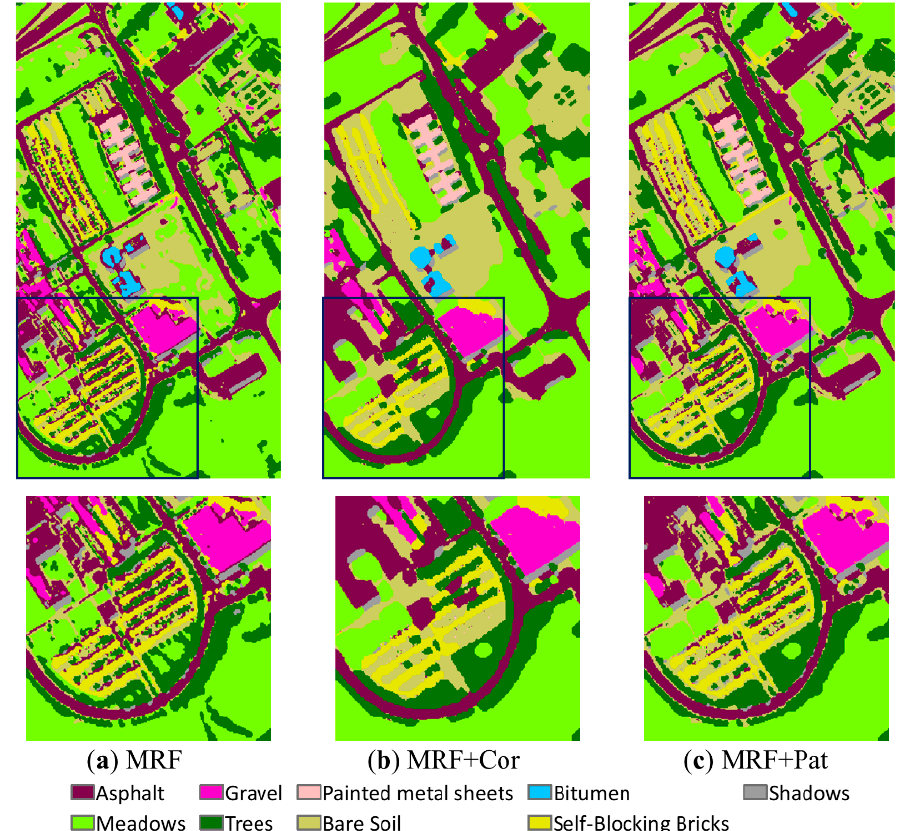
Figure 10. Contextual classification results based on the MLC for the ROSIS image: ( a ) MRF result and zoomed image, ( b ) MRF + Cor result and zoomed image, ( c ) MRF + Pat result and zoomed image.